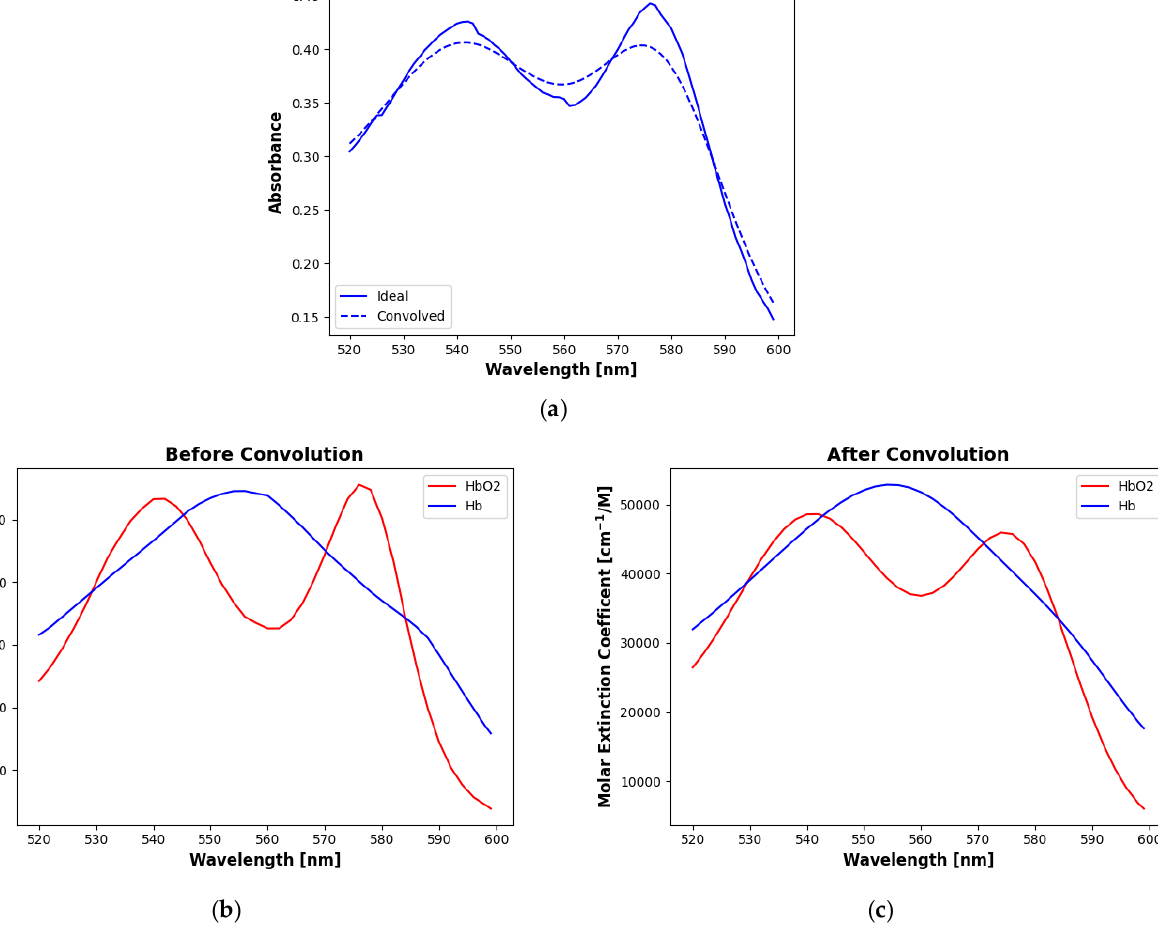
Figure 1. Effects of convolution with a 15 nm FWHM Gaussian filter. ( a ) Example spectrum before and after convolution. The other plots show molar extinction coefficients for oxy- and deoxyhemoglobin ( b ) before and ( c ) after convolution. Convolution flattens and broadens the distinctive peaks in the oxyhemoglobin curve, most significantly in the higher wavelength lobe, bringing it closer to the deoxyhemoglobin curve.